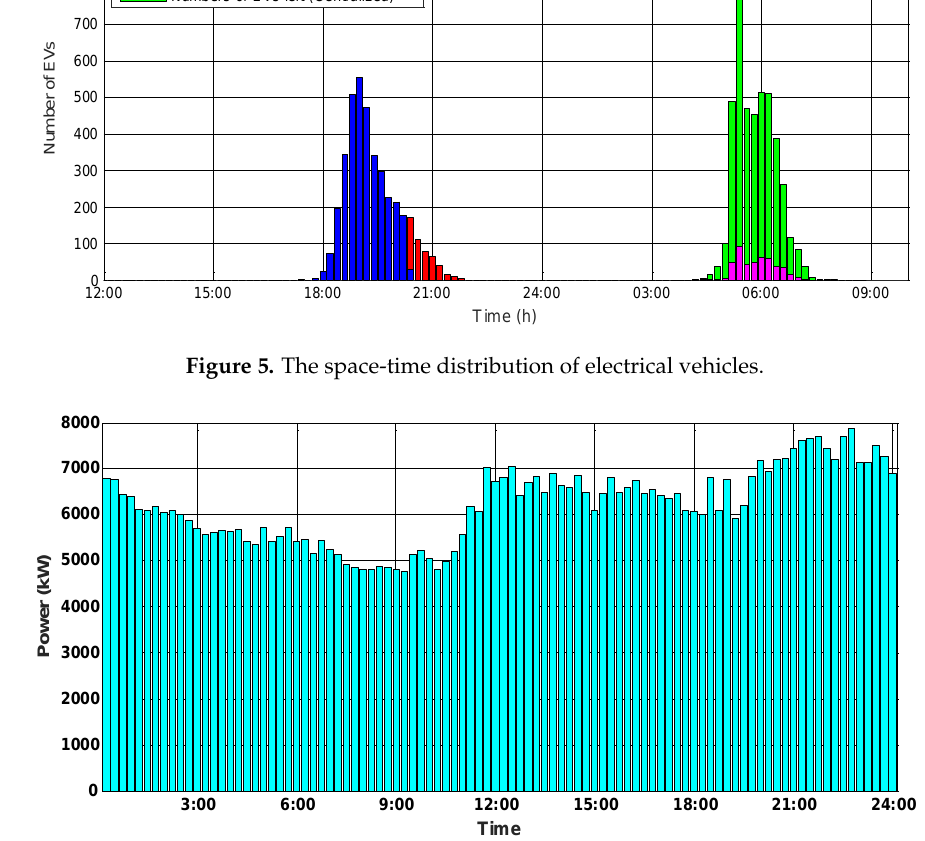
Figure 6. The consumers’ load demand curve in a typical day in the new town .